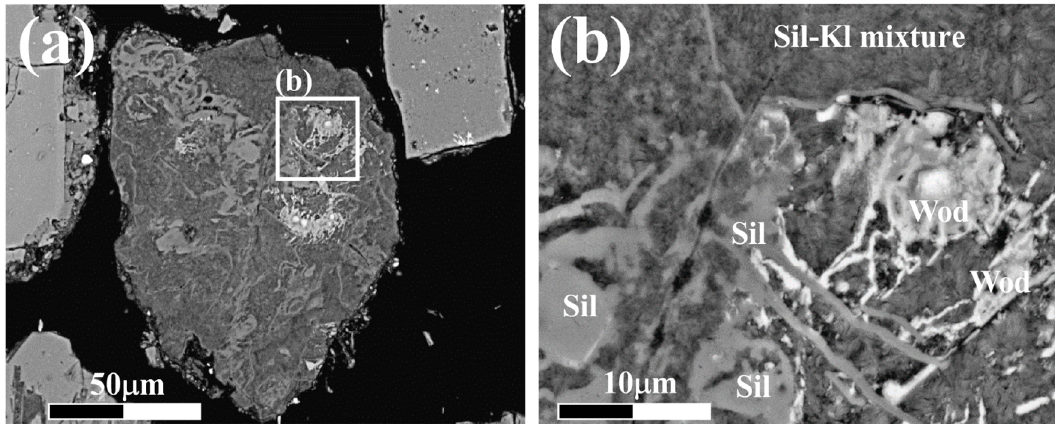
Figure 6. Representative backscattered electron images of Micro-wormy-vein woodhouseite-APS . ( a ): entire ash grain containing micro-wormy veins. The grain consists mainly of silica (Sil) and kaolin (Kl) minerals (ONTK-VA-015 in Table 2) ( b ) Micro-wormy vein APS cross-cut by siliceous micro-wormy veins in the matrix of fine-grained silica-kaolin mixtures.